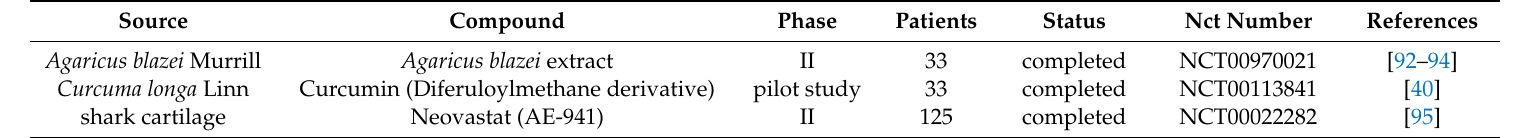
Table 7. Clinical trials of natural products about